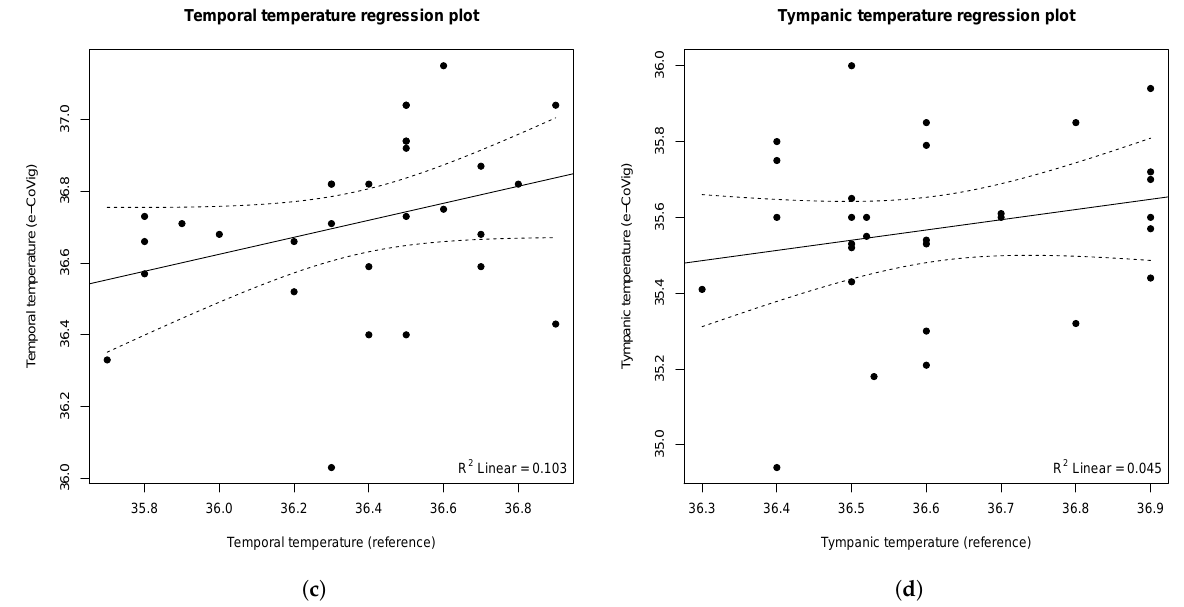
Figure 9. Regression plots representing the correlation between the measurements with the e-CoVig device and the standard reference device. ( a ) heart rate (in BPM); ( b ) SpO (in %); ( c ) temporal and ( d ) tympanic temperatures (in °C). The solid 2 line represents the regression line computed using unweighted least squares, while the dashed lines correspond to 95% confidence bands, depicting the upper and lower confidence bounds for all points on the fitted